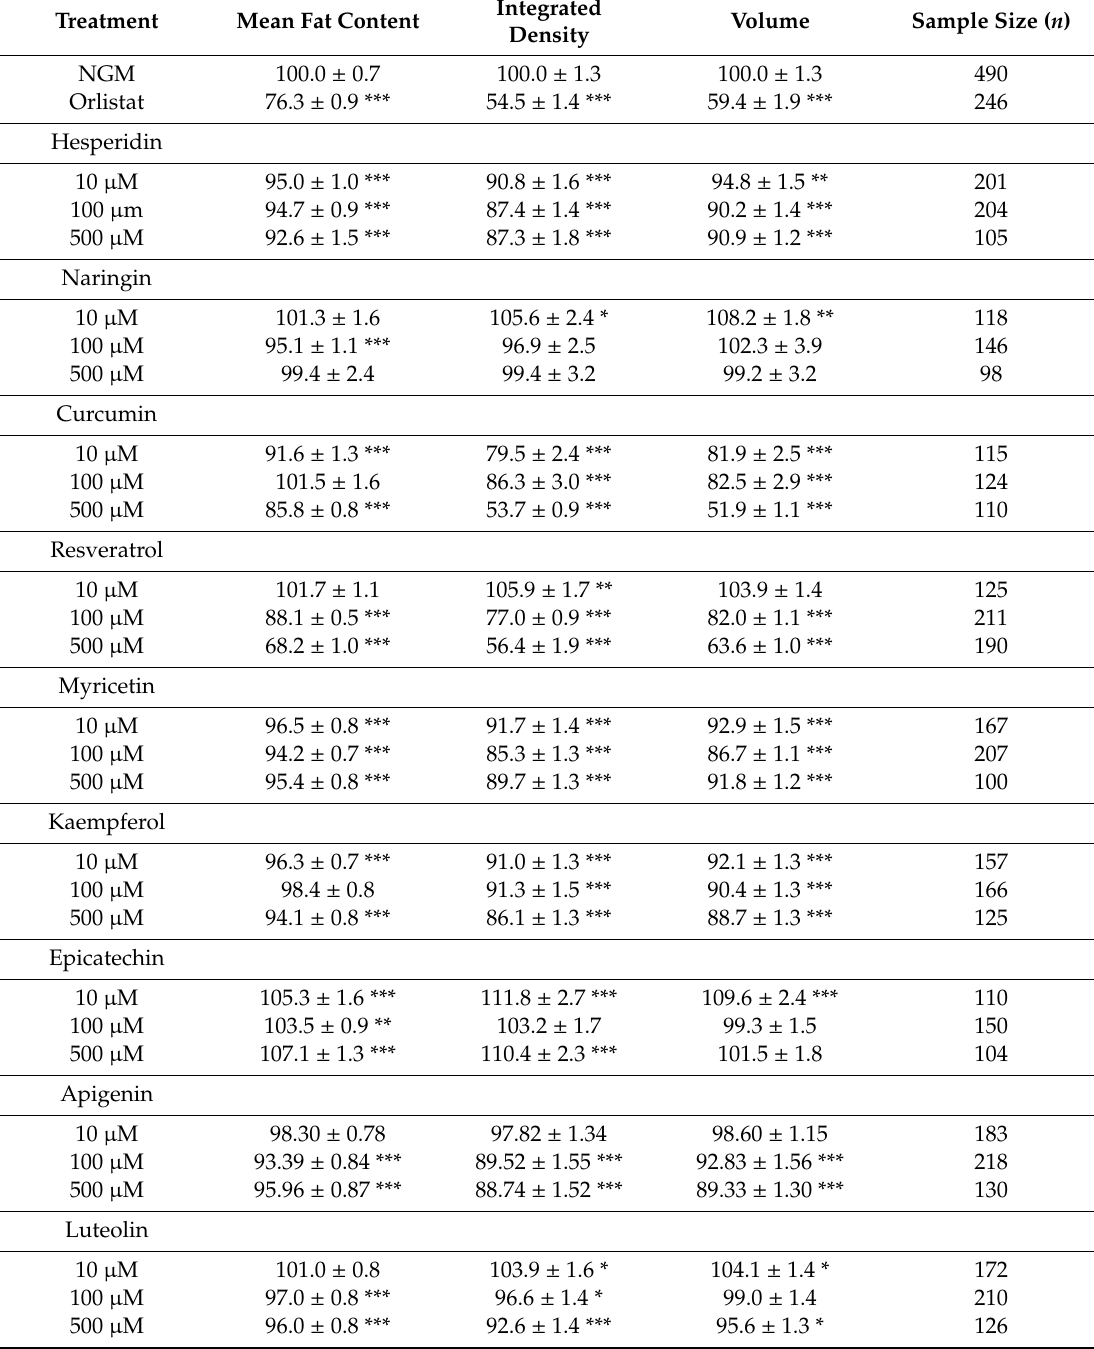
Table 1. C. elegans lipid quantification data (relative to NGM) obtained after phenolic compounds treatment and measured by Nile Red staining. Data correspond to the mean ± SEM. *, **, *** show the level of statistical significance of the di ff erences, p < 0.05, p < 0.01, and p < 0.001,